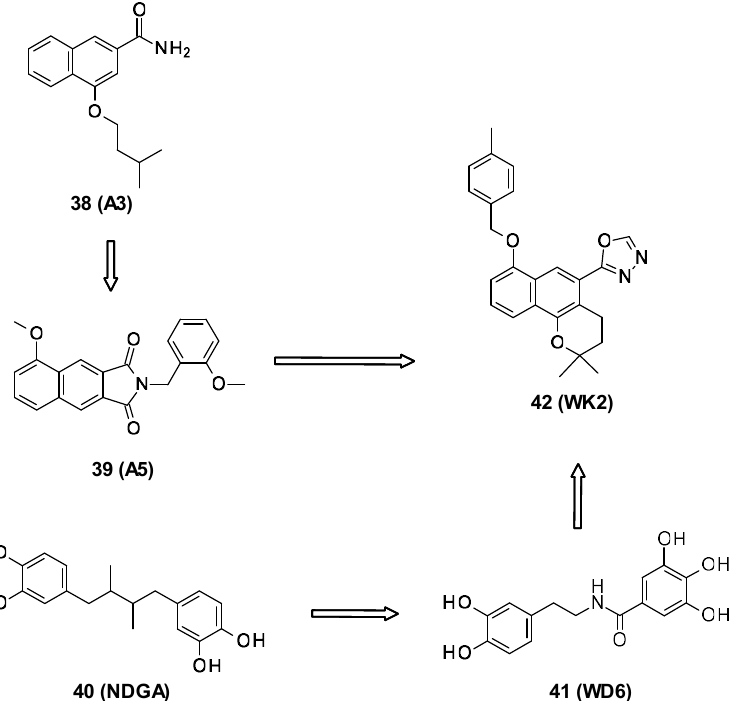
Figure 7. Structures of compounds A3 ( 38 ), A5 ( 39 ), NDGA ( 40 , nordihydroguaiaretic acid), WD6 ( 41 ), and WK2 ( 42 ).